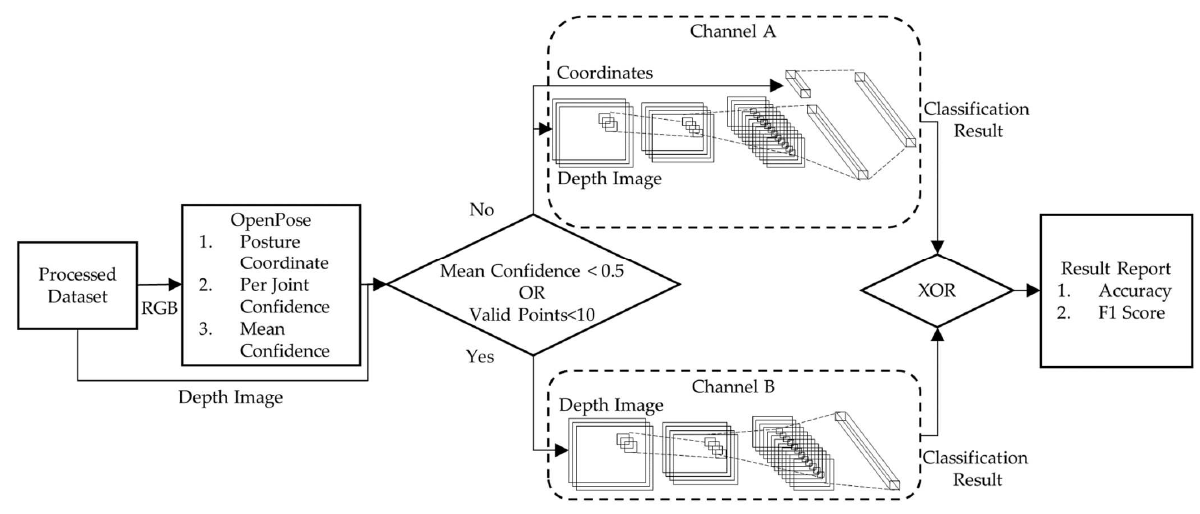
Figure 4. System application architecture to predict sleep posture from testing data after the models were trained.